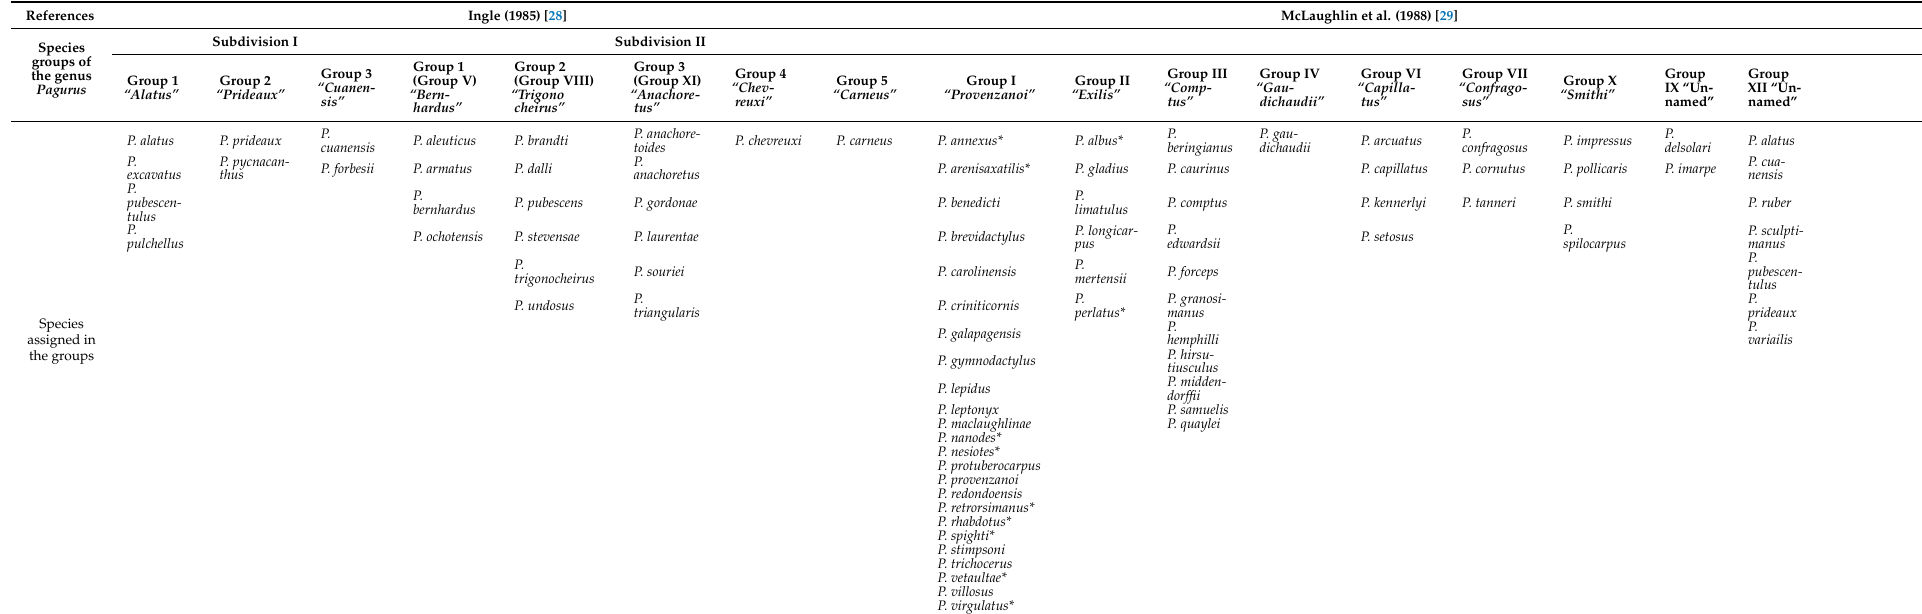
Table 1. Species groups of the genus Pagurus based on adults’ morphological